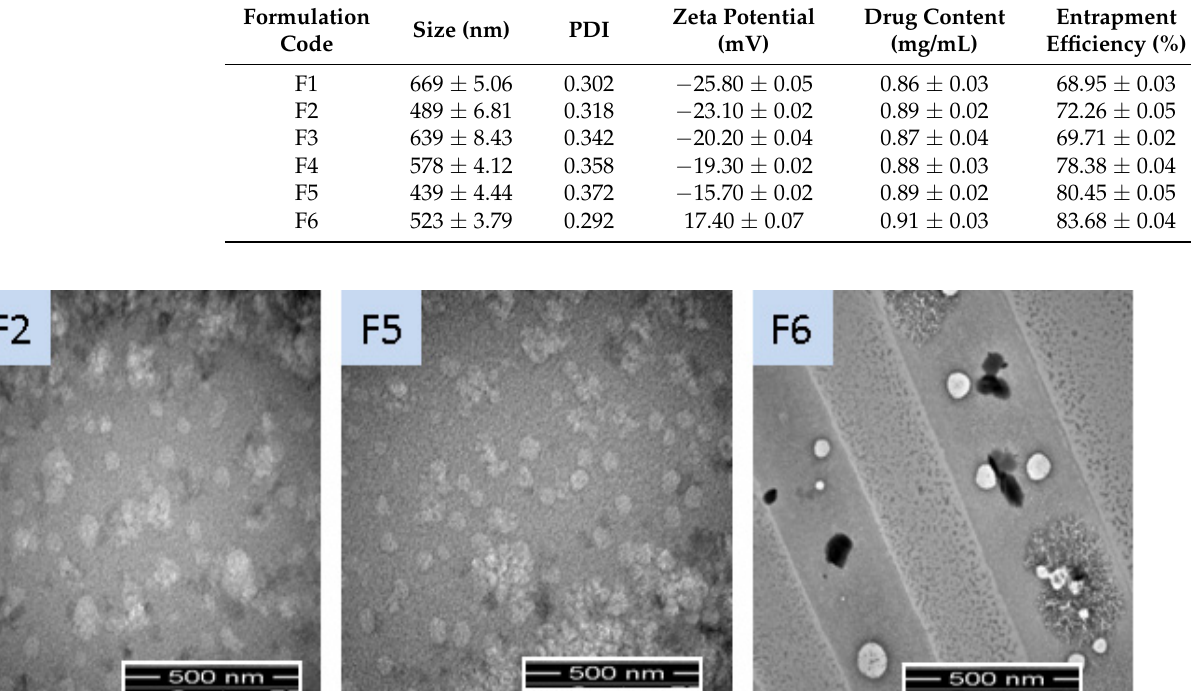
Figure 1. Morphology of optimized SLN formulations using TEM analysis.